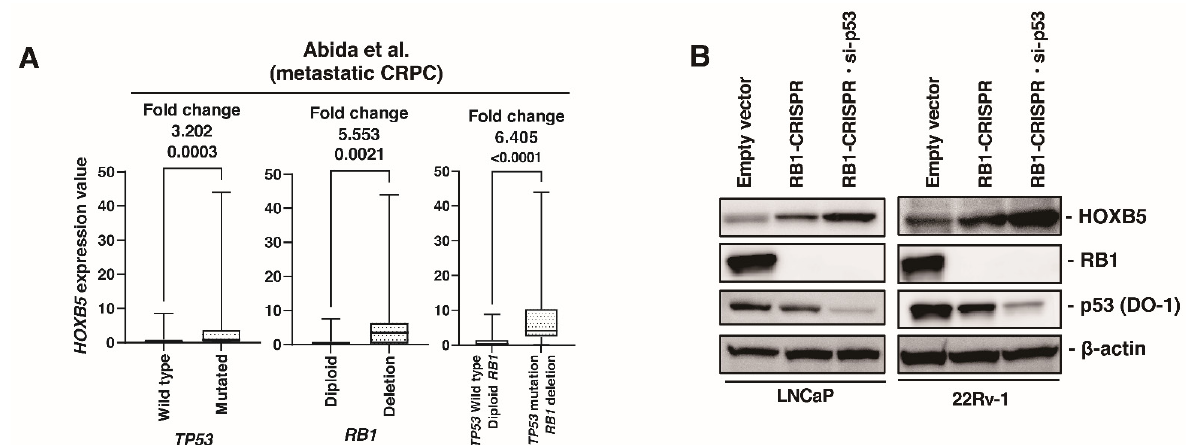
Figure 6. HOXB5 expression is upregulated in RB1 and p53 modulation. ( A ) Box plot of HOXB5 expression in wild type and mutated TP53, in diploid and deleted RB1, and TP53 wild type/diploid RB1 and TP53 mutation/RB1 deletion in the metastatic CRPC dataset (Abida et al.). Fold changes are indicated. ( B ) Western blotting of HOXB5, Rb1, and p53 (DO-1) in LNCaP and 22Rv-1 cells transfected with empty vector, RB1-CRISPR vector, RB1-CRISPR vector and si-p53. β -actin was used as a loading control.